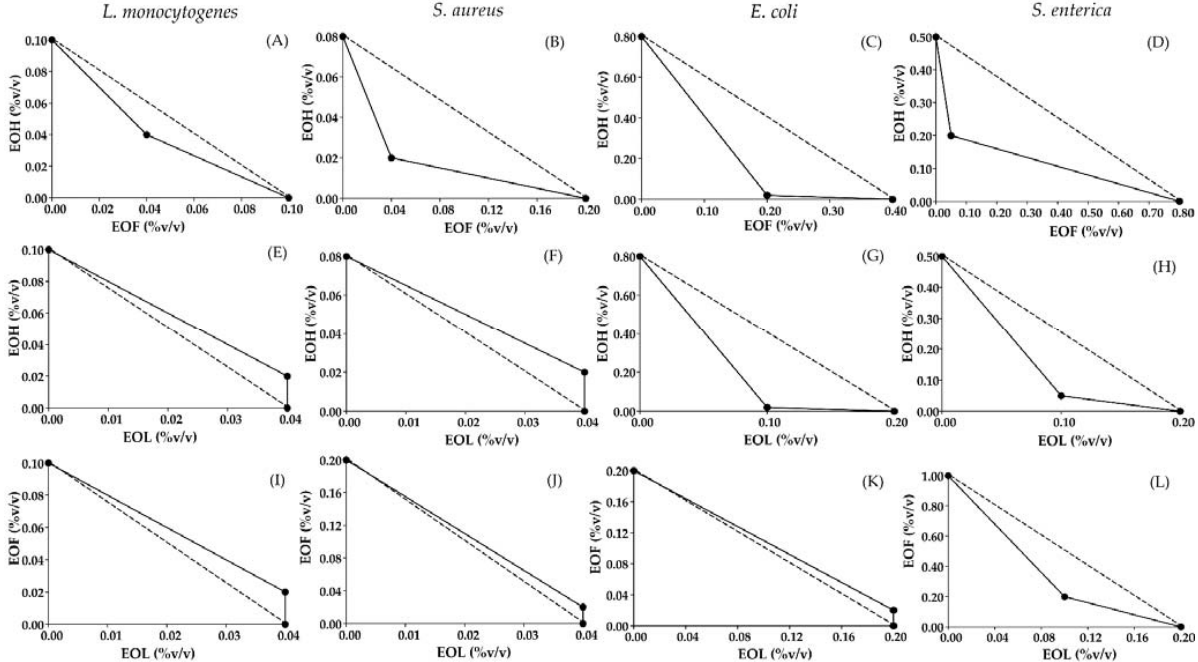
Figure 1. ( A – L ) Minimum inhibitory concentration (MIC) isobolograms of EOF, EOH and EOL combinations against foodborne microorganisms. Straight lines (dotted line) represent the reference additive lines and points correspond to mean MIC data from checkerboard assay. On the MIC isobolograms, additive interactions are represented as a straight line, while the variation of linearity to the right or left of the additive line is interpreted as antagonism or synergism, respectively [42].